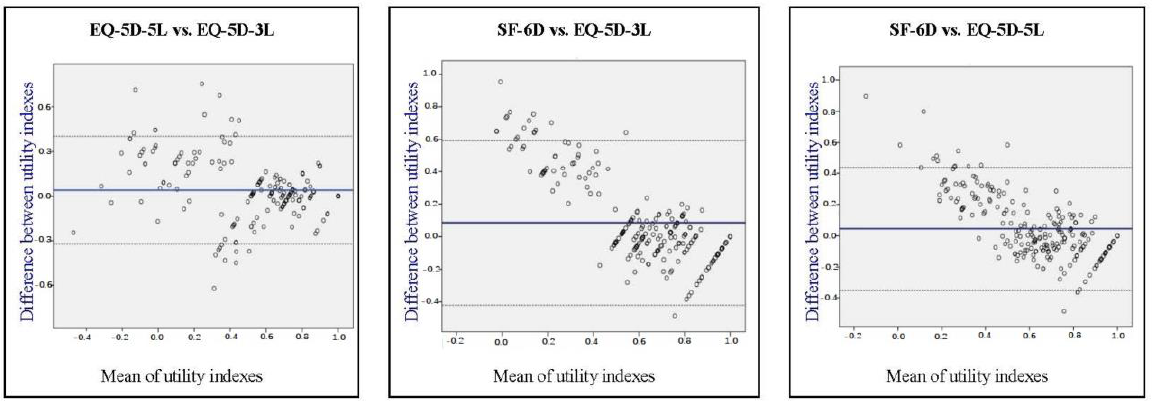
Figure 3. Bland–Altman plots of utility differences between the instruments (in vertical